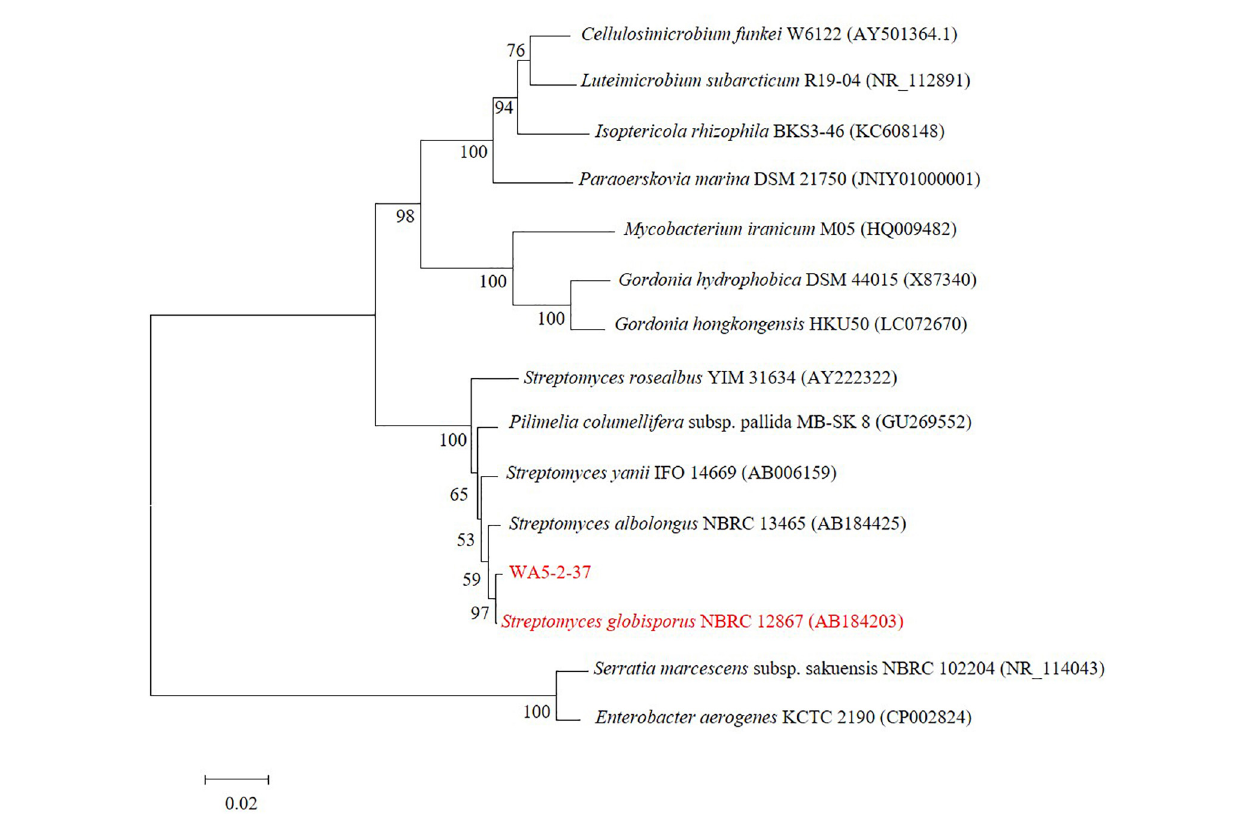
FIGURE 2 | The phylogenetic tree of strain WA5-2-37. Maximum-likelihood phylogenetic tree based on 16S rDNA gene sequences showing the positions of strain WA5-2-37, the type strains of other Streptomyces and representatives of some other related taxa. Only bootstrap values (expressed as percentages of 1,000 replications) greater than 50% are shown at branching points. Bar, 0.02 substitutions per nucleotide